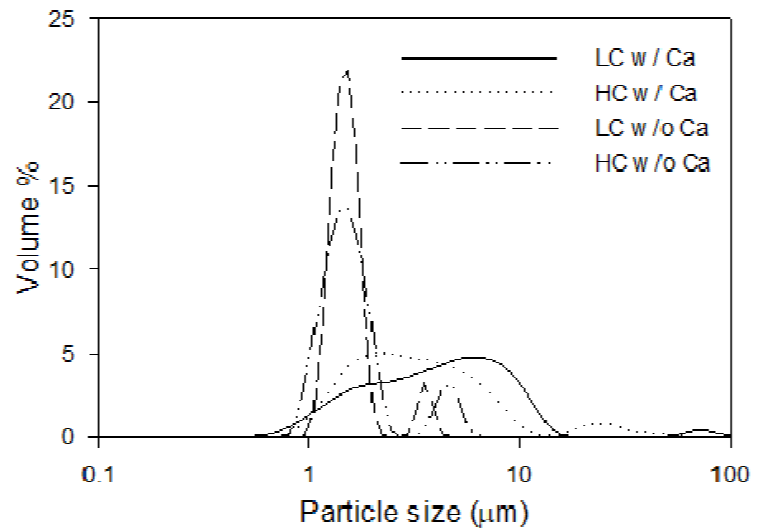
Figure 3. Volume-weighted size distribution of high surface charge (HC) and low surface charge (LC) PS–PAA particles with and without calcium ions present.